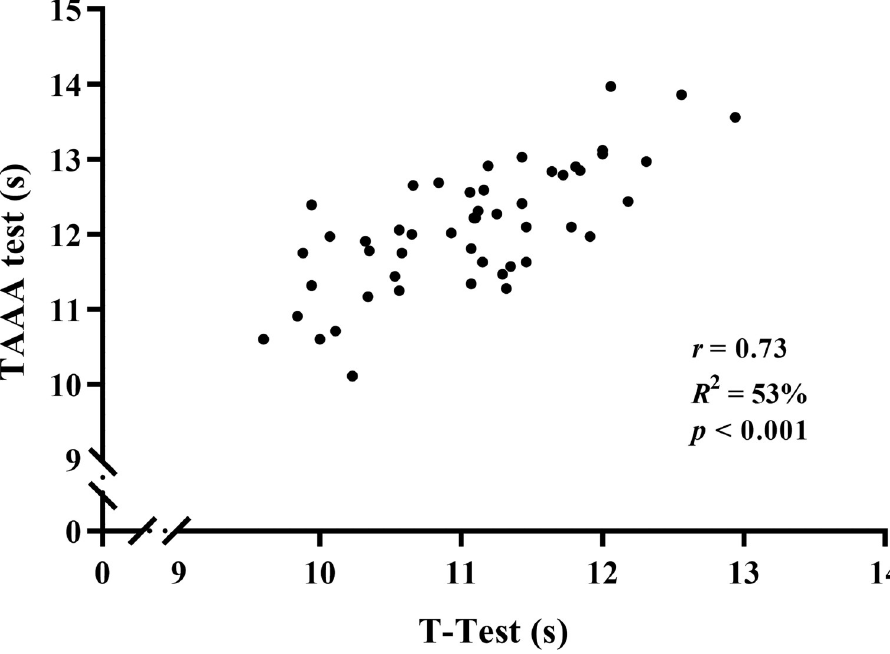
Fig 3. Scatter plot (n = 50) of the relationship between the agility T-Test and the agility function of the taekwondo-specific aerobic-anaerobic-agility (TAAA) test.